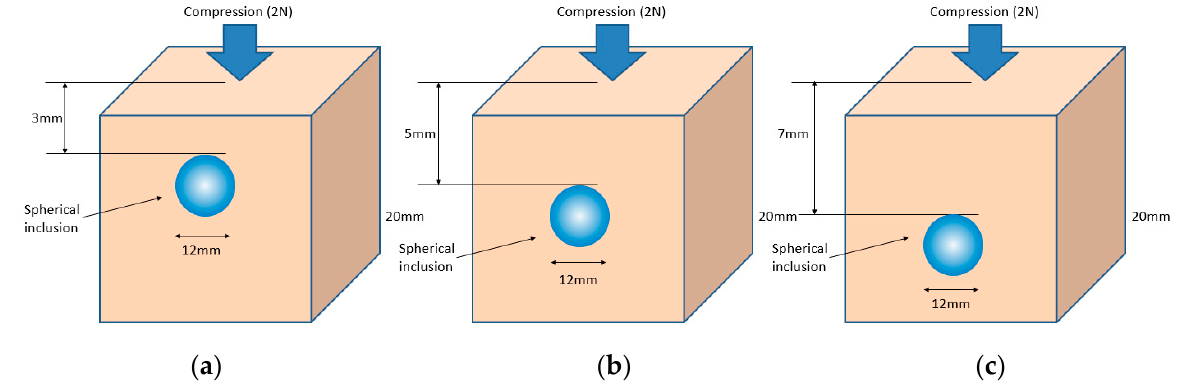
Figure 23. ( a ) 3-mm-deep tissue included, ( b ) 5-mm-deep tissue included, ( c ) 7-mm-deep tissue included.